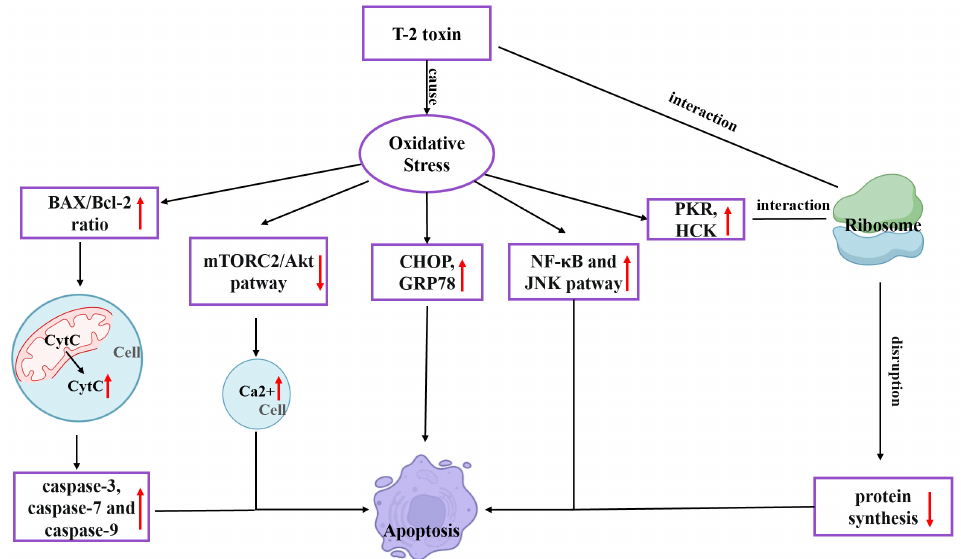
Figure 1. Mechanism of the toxic effects of T-2 toxin.